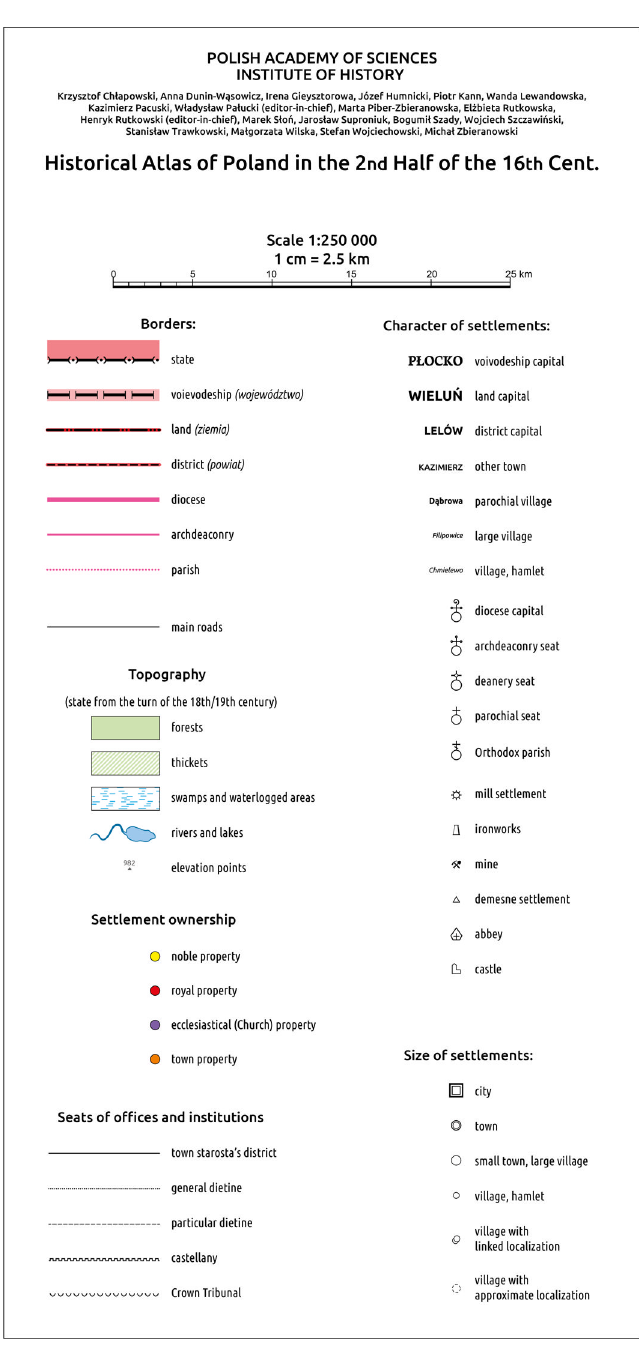
Fig. 2. Legend of the main detailed map at the scale of